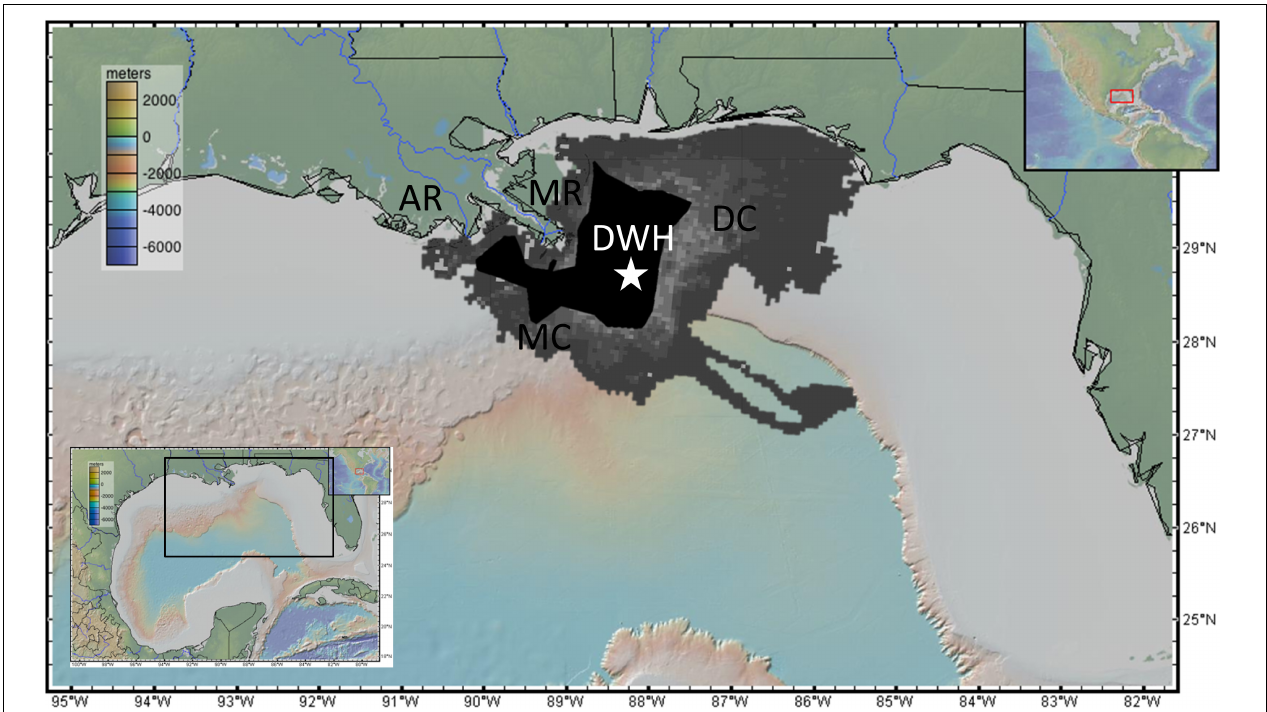
FIGURE 1 | A map of the northern Gulf of Mexico including the surface spatial extent of petroleum (MacDonald et al., 2015) and dispersant application (Environmental Response Management Application [ERMA], 2020), the locations of the Mississippi River (MR) and Atchafalaya River (AR) terminations, the Mississippi Canyon (MC) and DeSoto Canyon (DC), and the Deepwater Horizon (DWH; white